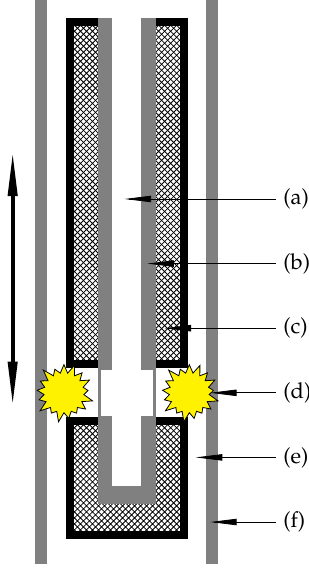
Figure 2. Schematic design of the polishing head: ( a ) electrolyte; ( b ) metal core (cathode, stainless steel); ( c ) insulator (polyether ether ketone (peek)); ( d ) adjustable polishing head gap and the active plasma (yellow); ( e ) gap between the inner pipe surface and the polishing head; ( f ) moveable pipe (anode, stainless